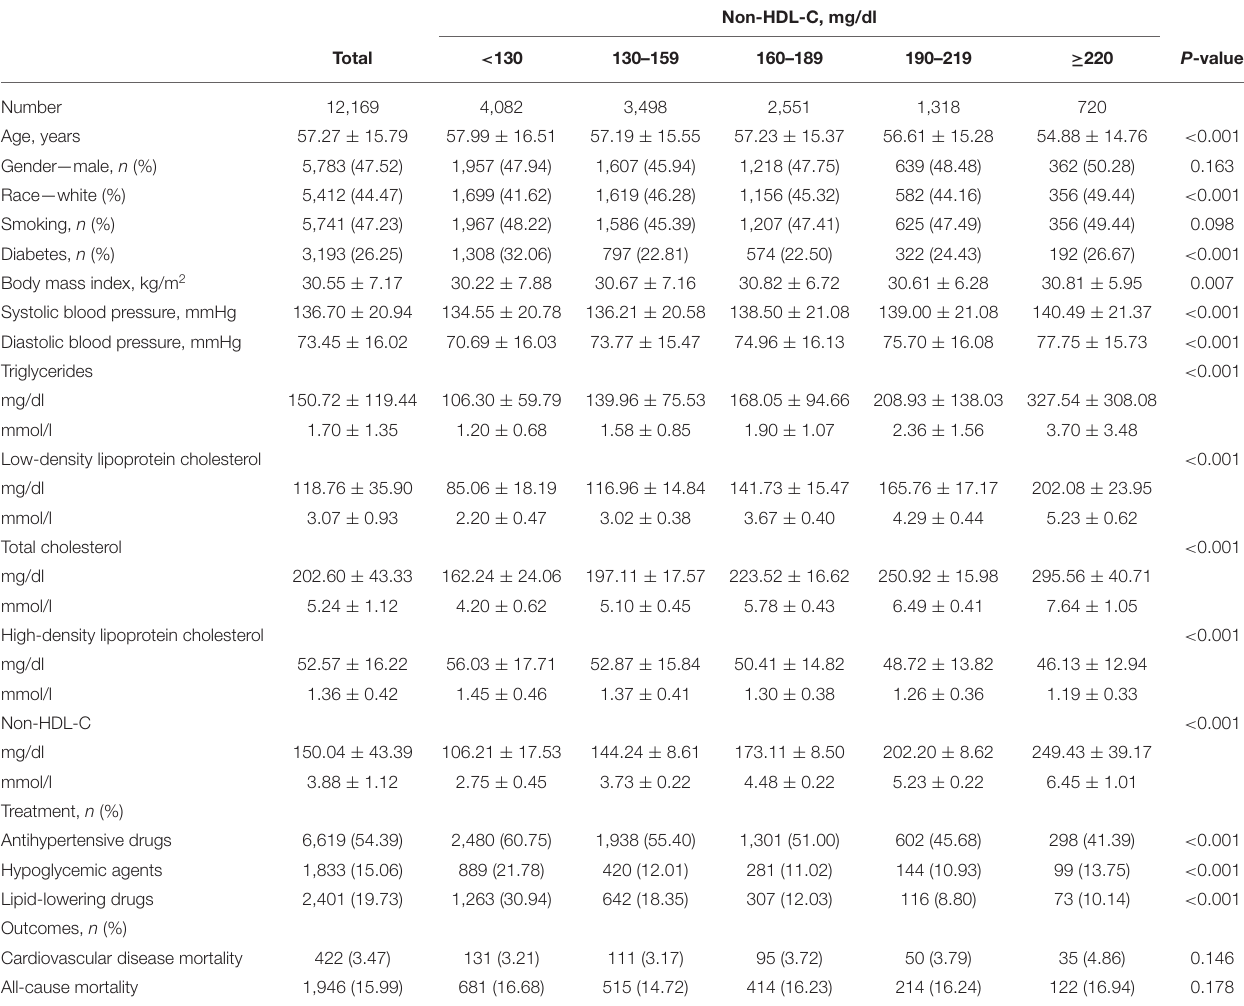
TABLE 1 | Demographic and clinical characteristics according to non-HDL-C levels.